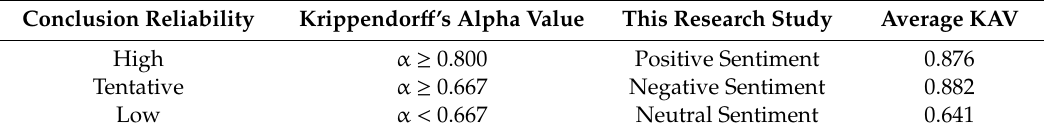
Table 2. LDA topics results description.